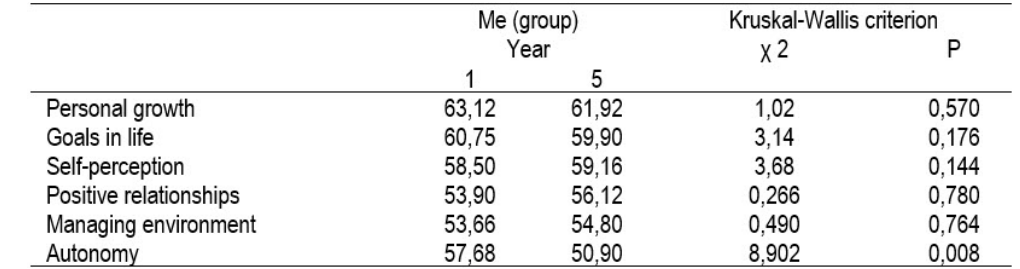
Results of diagnostics of dynamics in indicators of student psychological well-being according to K. Ryff’s “Scale of Psychological